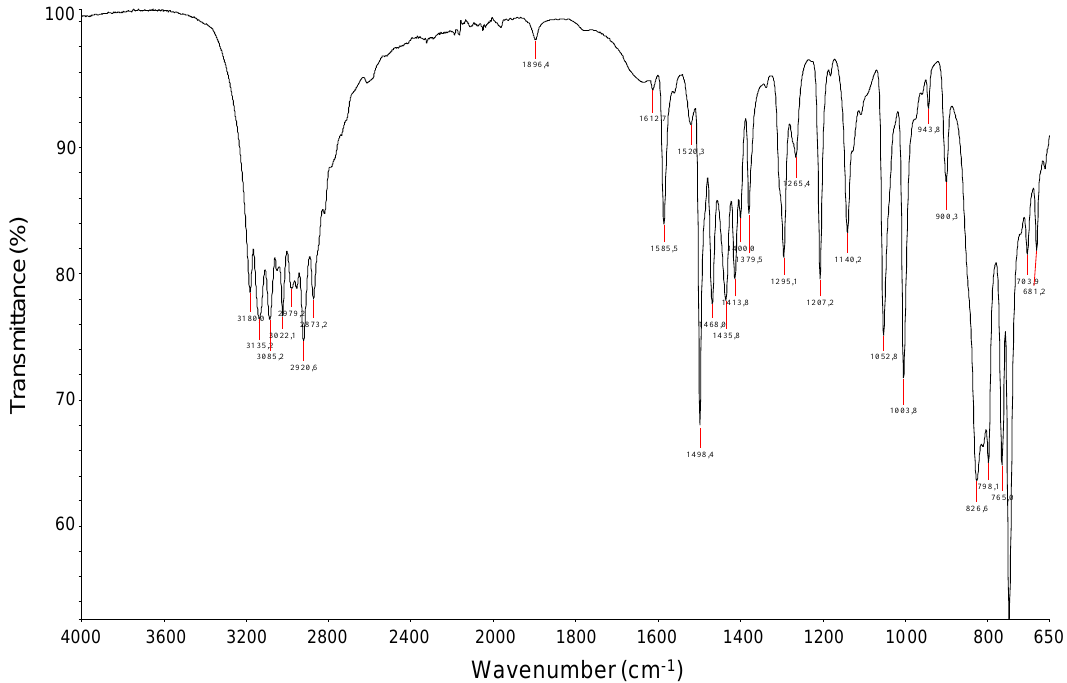
Figure 1. Fourier transform infrared spectroscopy (FTIR) spectrum of the free H 2 DMPMB ligand.